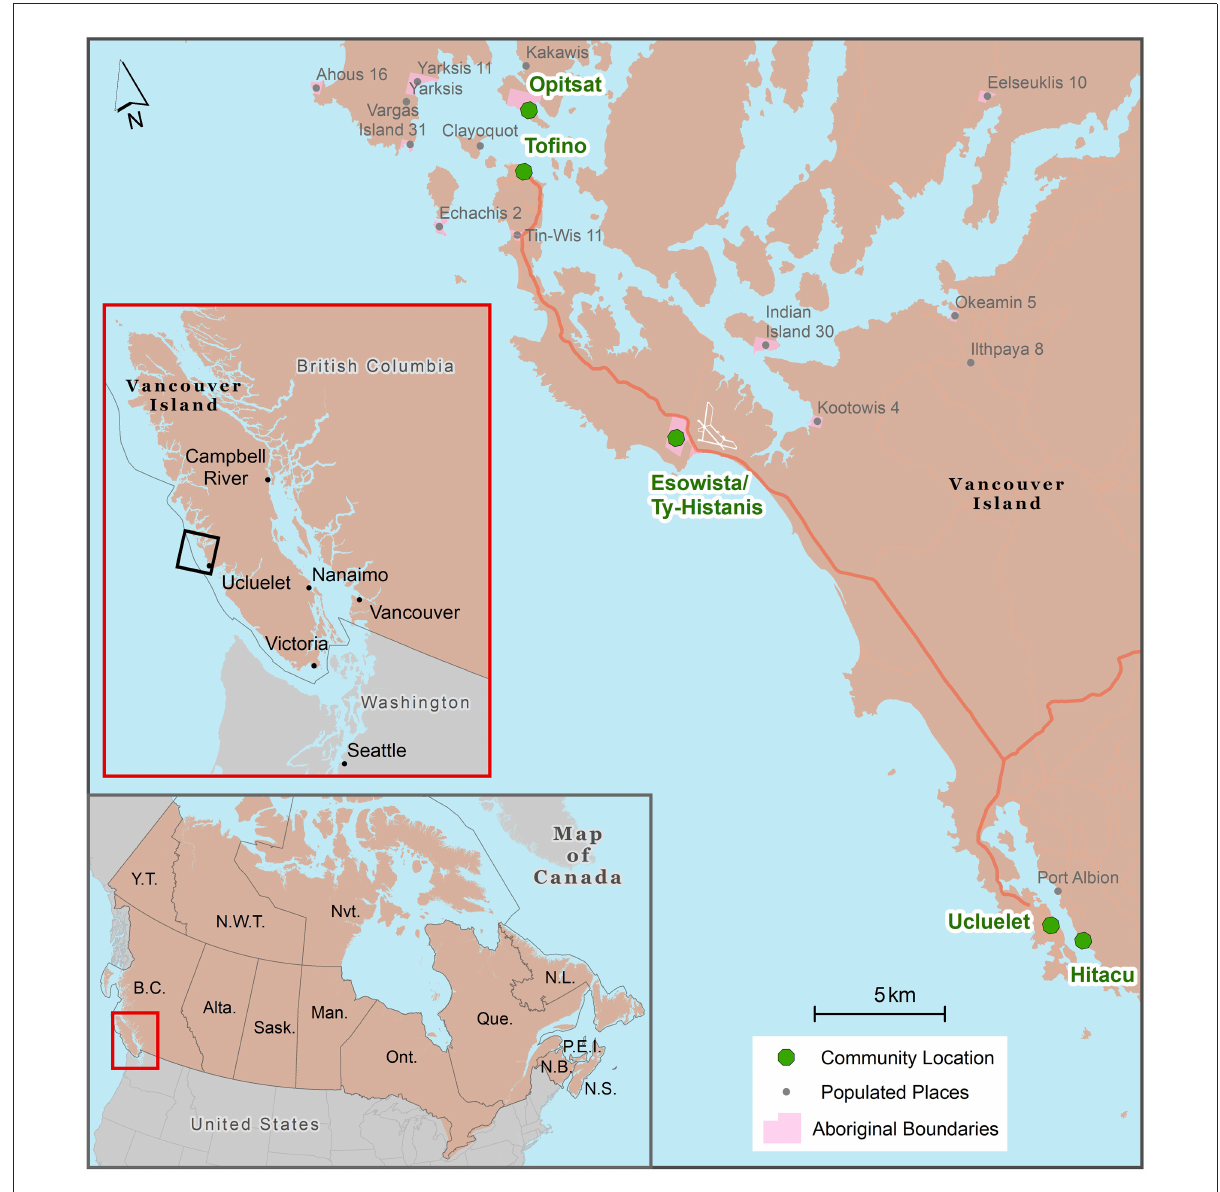
FIGURE1 Map of the CSBR showing research community